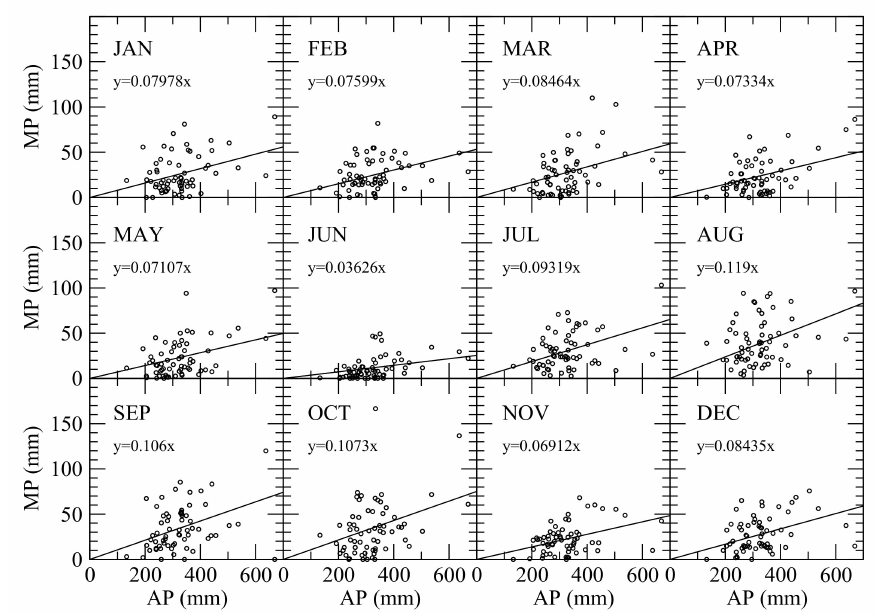
Figure 7. Scatter plots and the best-fit of monthly precipitation vs. annual